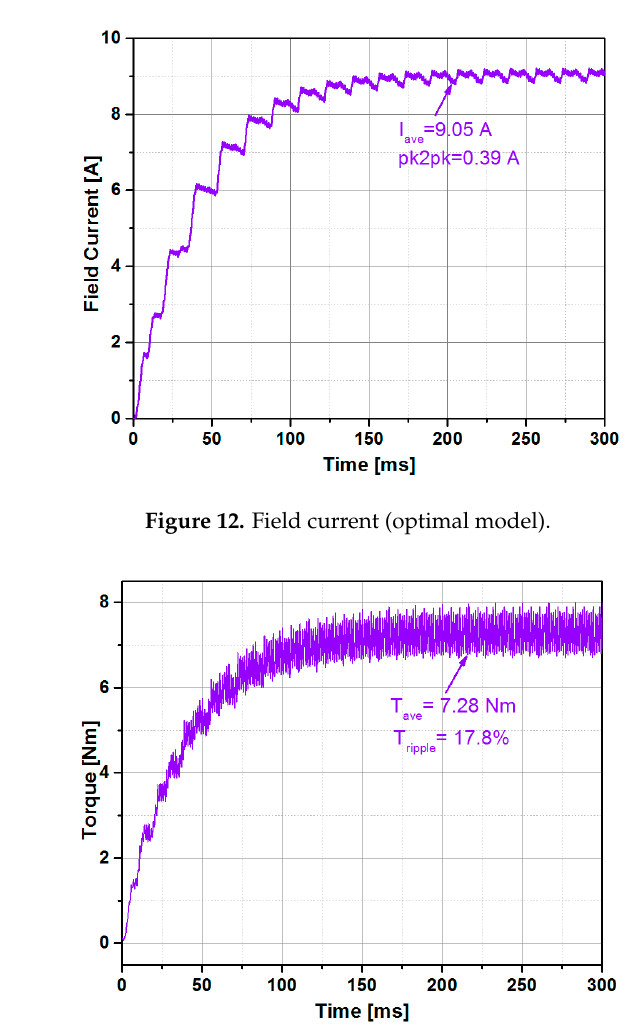
Figure 13. Torque of the BL ‐ WRSM (optimal model).